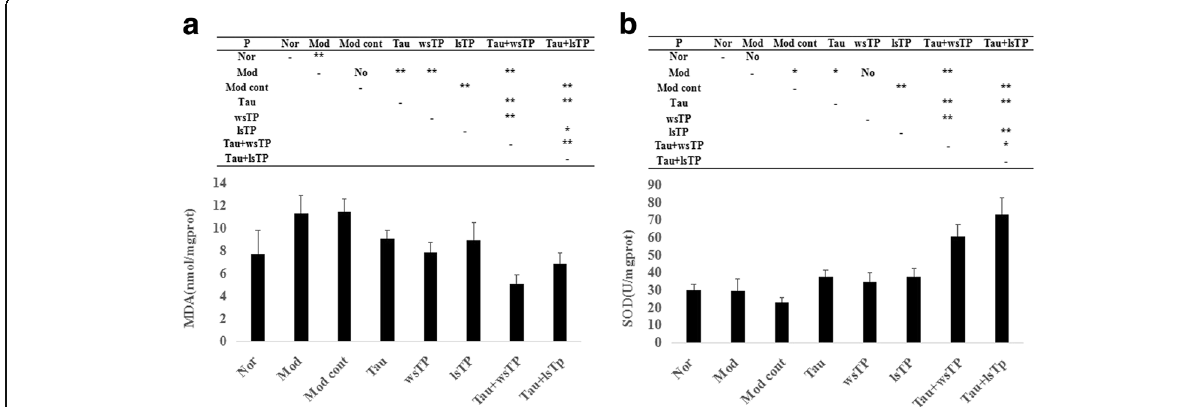
Fig. 2 Effect of taurine and/or TPs on hepatic oxidative stress. Hepatic MDA levels in the model group and the model control group increased significantly compared with the normal group ( P < 0.01), but no significant differences in hepatic SOD activities between each two groups were shown ( P > 0.05) ( a , b ). Taurine treatment could decrease hepatic MDA levels ( P < 0.01) and increase hepatic SOD activities in NASH rats ( P <